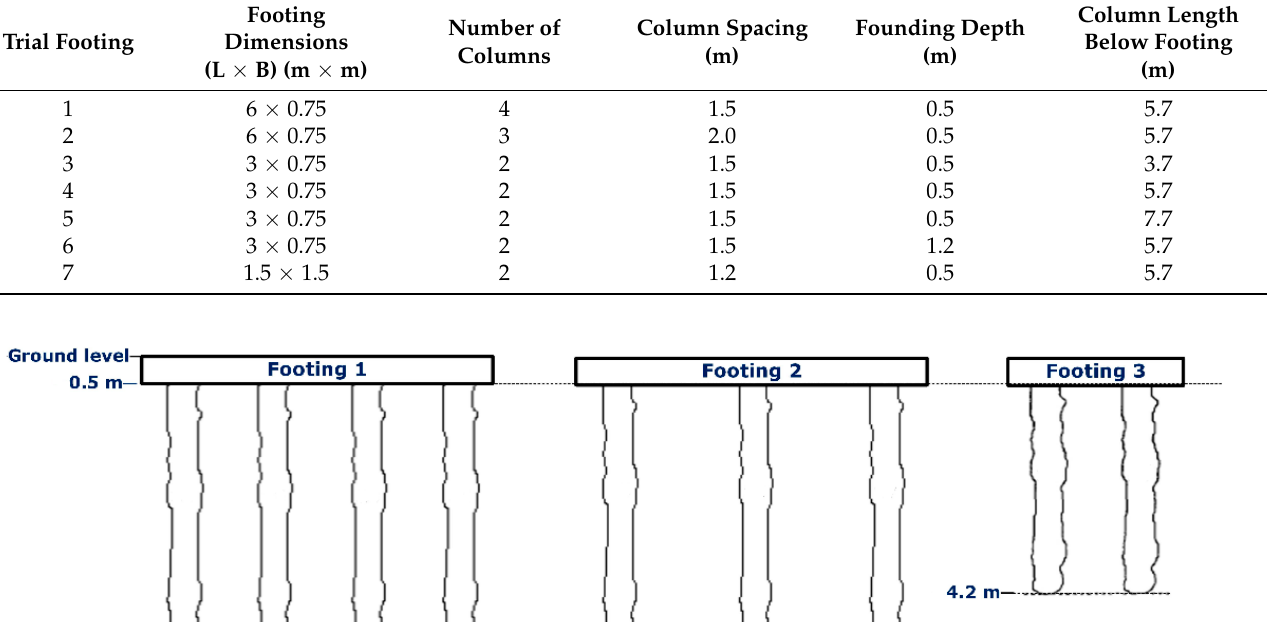
Table 1. Bothkennar trial footing arrangements.